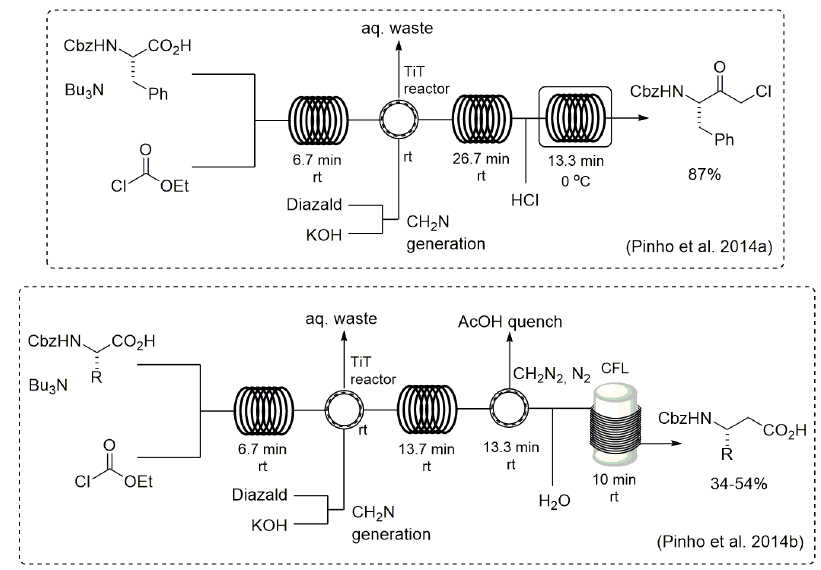
Figure 15 - Generation of diazomethane in a tube-in-tube (TiT) reactor.